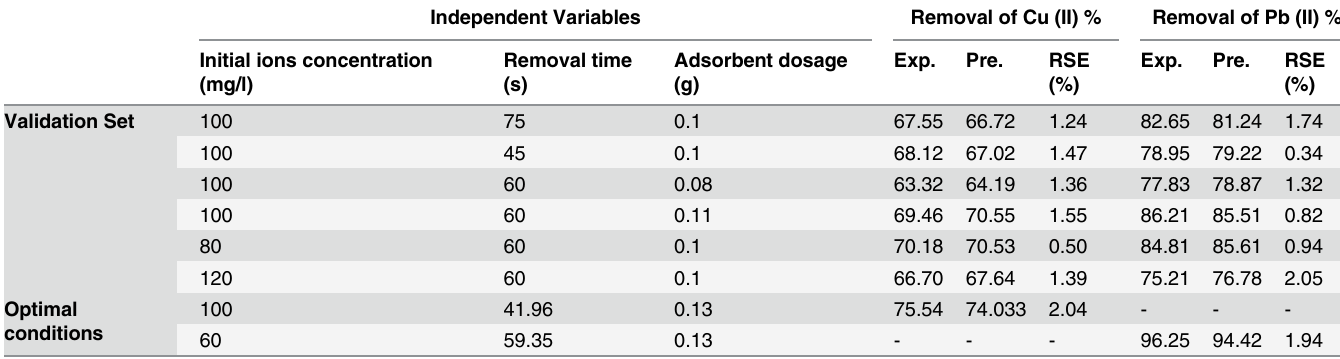
Table 4. Predicted and observed response values for validation of models and optimum